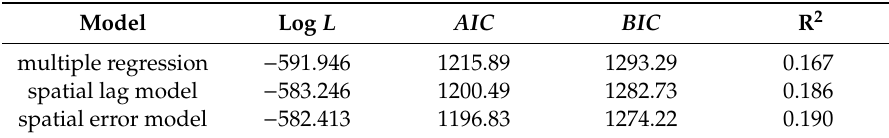
Table 8. Evaluation of the models under study.